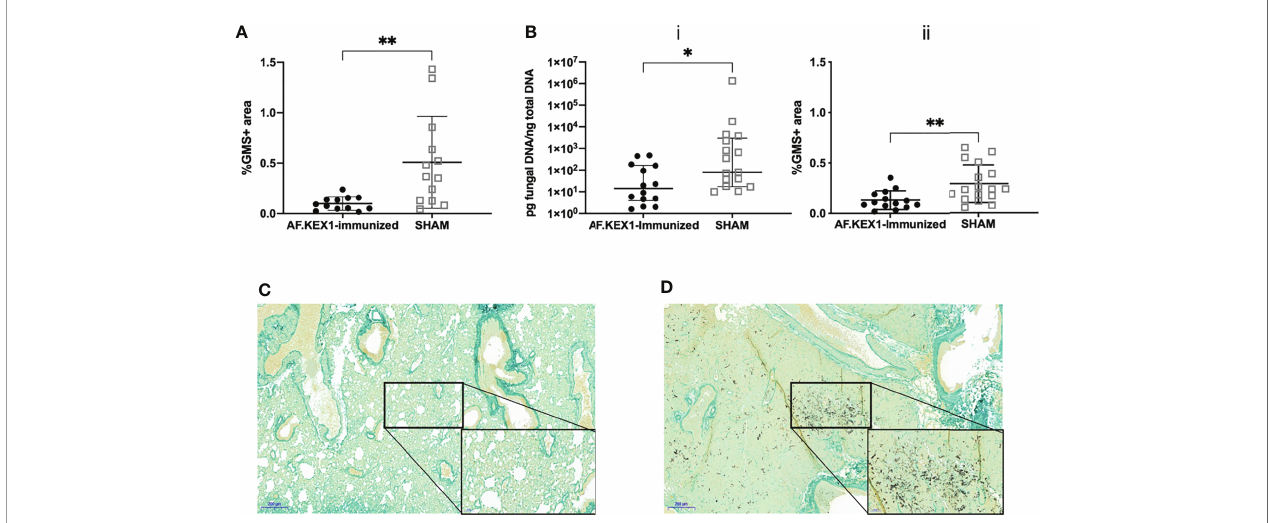
FIGURE 4 | Lung fungal burden following A. fumigatus challenge. (A) Quanti fi cation of fungal burden in the lungs of tacrolimus/hydrocortisone-immunosuppressed mice by %GMS+ area. (B) Quanti fi cation of the fungal burden in the lungs of cortisone acetate-immunosuppressed mice using (i) qPCR of fungal DNA and (ii) Gomori ’ s methenamine silver (GMS) staining. (C) GMS staining of the lungs of cortisone acetate-immunosuppressed mice following vaccination with AF.KEX1 and Af293 challenge or (D) SHAM vaccination and Af293 challenge (20x magni fi cation). Mann-Whitney rank tests were performed to compare cohorts. ** p < 0.01, * p < 0.05.